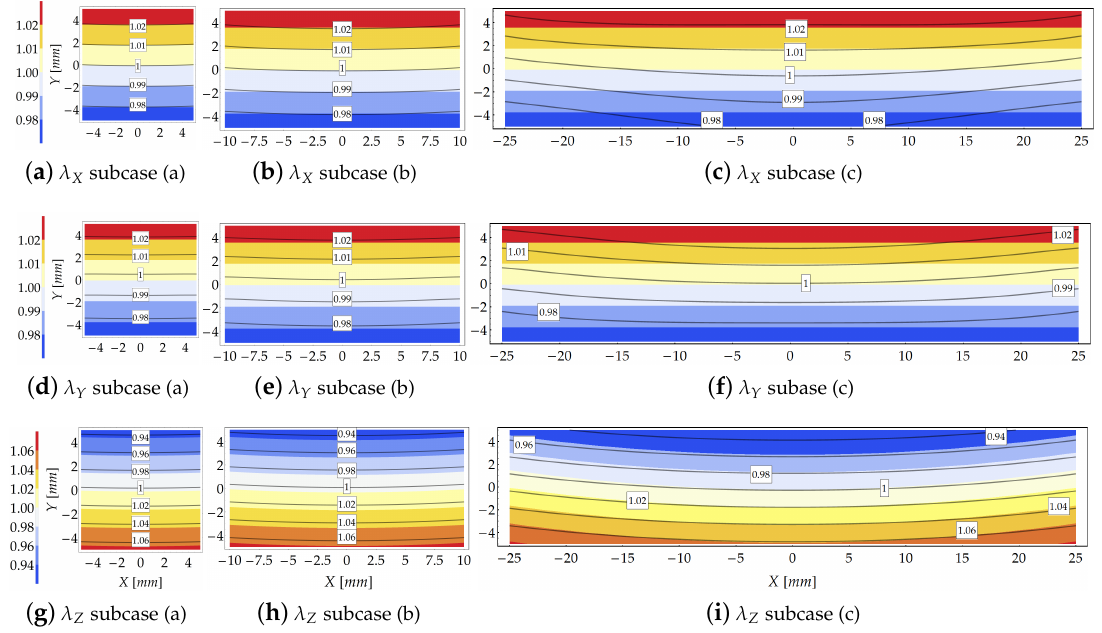
Figure 5. Study case A 1 at load increment 3 ( µ = 100): Comparison in terms of stretches provided by the theoretical model (contour plot) and the FE solution (solid isolines with boxed value).